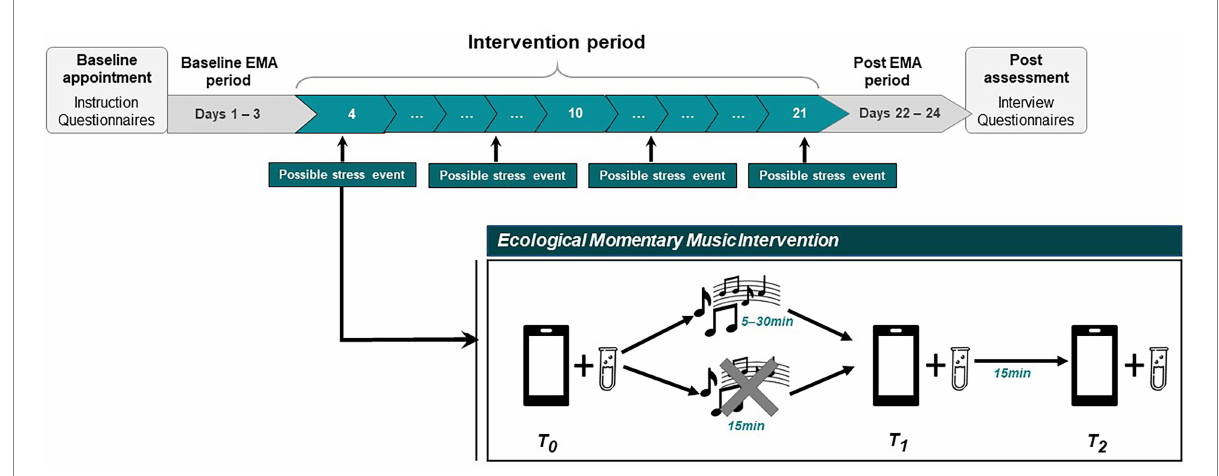
FIGURE 1 Schematic overview of the course of the study. During the 18-day intervention period, participants are prompted six times per day to report whether they feel stressed at the moment (“yes”/”no”) and are instructed to self-initiate a data entry each time they feel stressed. Upon reporting a momentary stress experience (T 0 ), participants are encouraged to listen to their study playlist, which can be complied with or rejected. Post-(non-)music listening assessments (T 1 , T 2 ) are included to capture immediate and time-delayed effects on subjective stress levels and biological stress markers (salivary cortisol, salivary alpha-amylase). EMA, ecological momentary assessment. Tube icon provided by